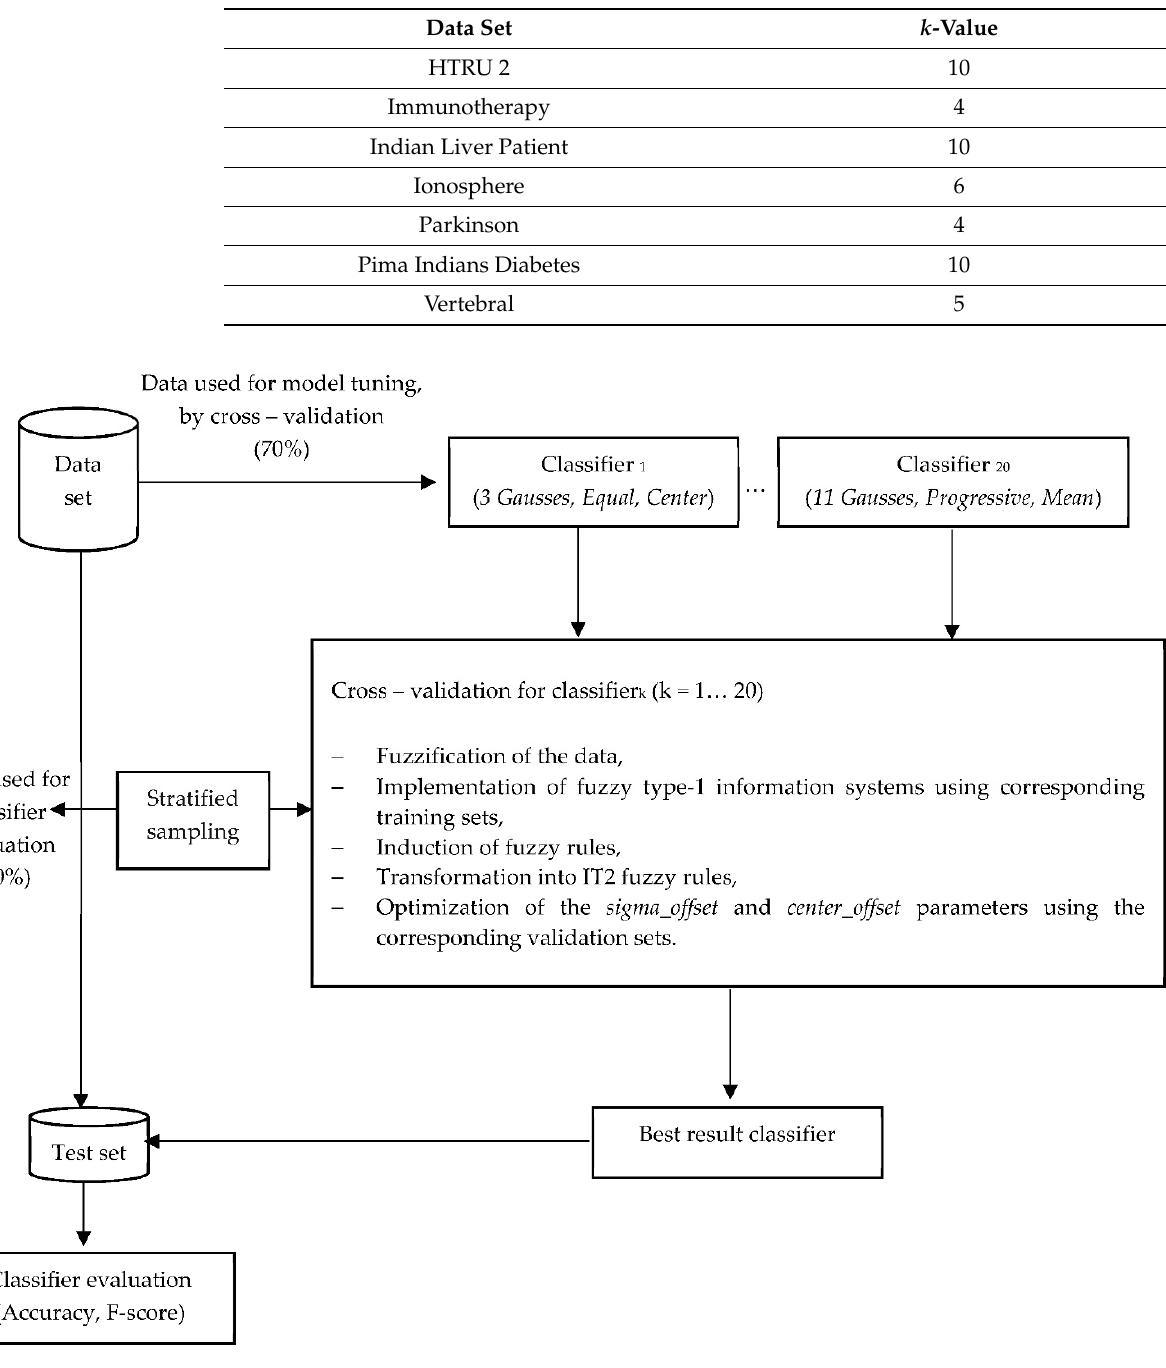
Figure 7. Experiment information flow.